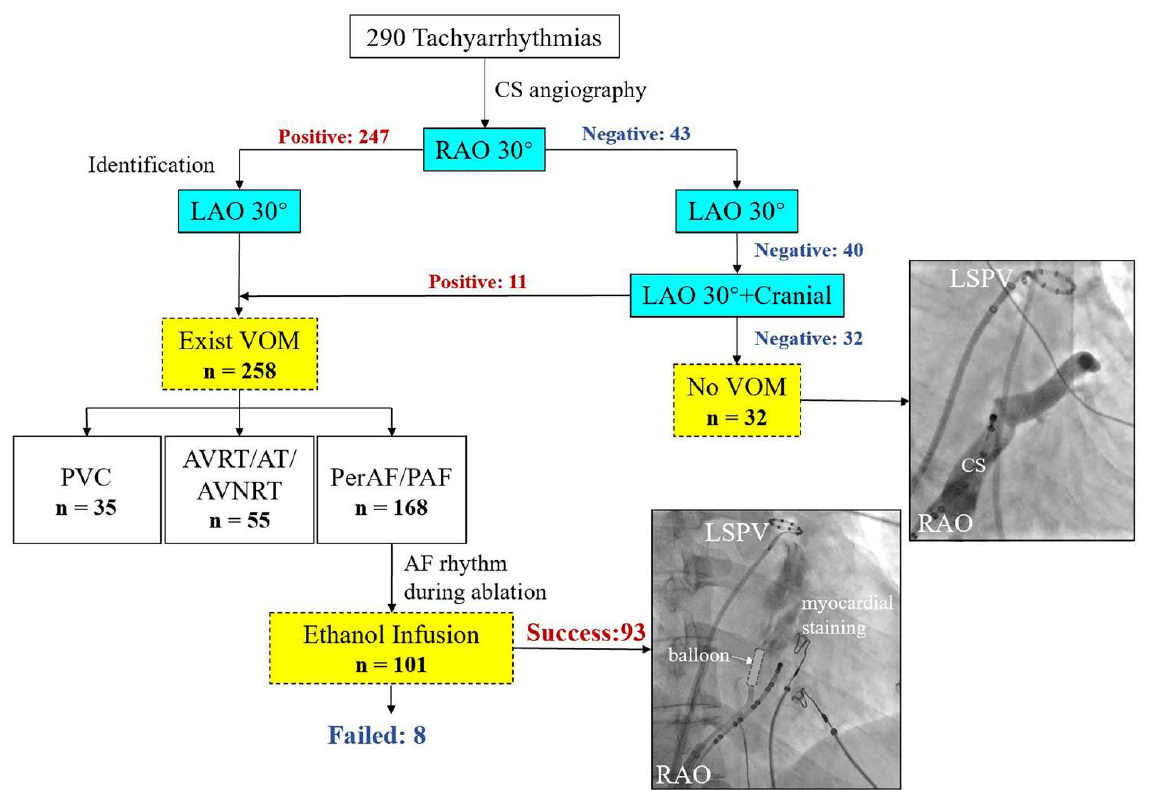
Figure 1. Flowchart of CS angiography, VOM angiography, and ethanol infusion procedure. AF = atrial fibrillation; AT = atrial tachycardia; AVNRT = atrioventricular nodal reentrant tachycardia; AVRT = atrioventricular reentrant tachycardia; CS = coronary sinus; LAO = left anterior oblique; LSPV = left superior pulmonary vein; RAO = right anterior oblique; PAF = paroxysmal atrial fibrillation; PerAF = persistent atrial fibrillation; PVC = premature ventricular contraction; VOM = vein of Marshall.